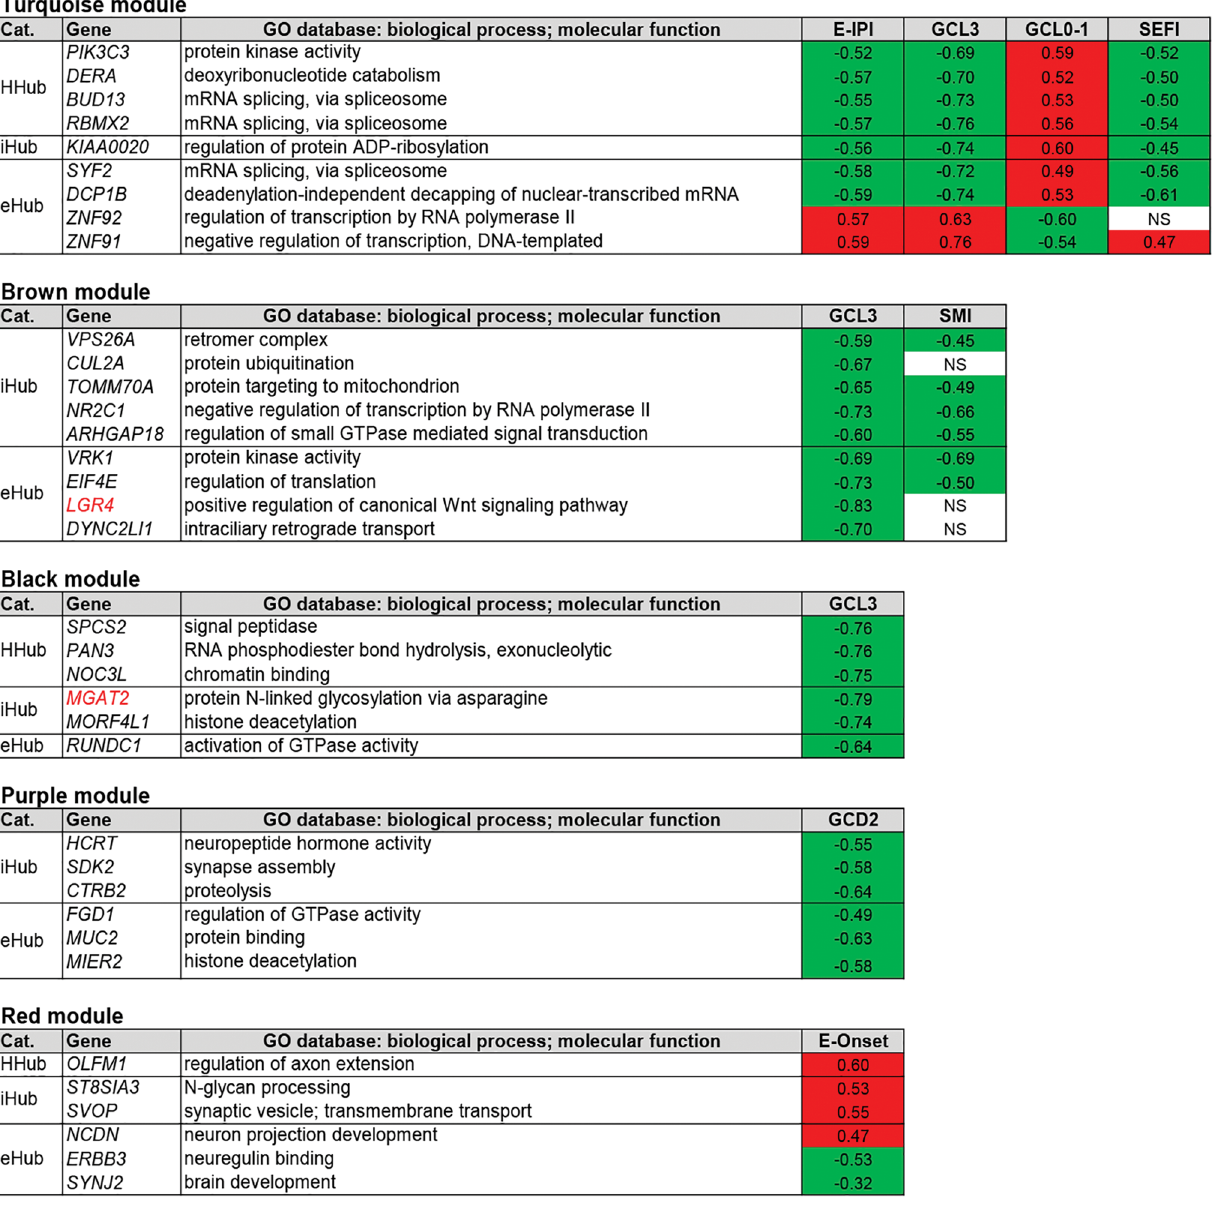
Figure 5. High hierarchy genes (Hhubs, iHubs, and eHubs) of the meta-module II present in modules highly associated with at least one trait. Each HH gene is identified by its hierarchical categorization and GO biological process or molecular function. Genes that are HH and HGS (see Table 2) appear in red lettering. Columns in red or in green indicate genes with positive (i.e. hyper-expressed) or negative (i.e. hypo-expressed) GS values for a specific trait, respectively. NS indicates gene with non-significant ( P ≥ 0.05) GS value for the specific trait. E-IPI stands for early IPI; E-Onset stands for early onset; SEFI stands for severe executive function impairment; SMI stands for severe memory impairment. The abbreviations-GCD2, GCL0-1, GCL3-refer to histopathological alterations, as described in the Results and Material and Methods In the yellow module nine out of the eleven HH genes are positively correlated with GCD2 (Fig. 4). The HHub TANC2 and the eHub SLC25A18 , both hyper-expressed, belong to the glutamatergic excitatory system 36,37 , whose dysfunction leads to hyperexcitatory neural networks and neurotoxicity 38 . The iHub SPOCK1 , also hyper- expressed, encodes the proteoglycan testican, which is expressed in hippocampal pyramidal neurons and has a functional role in reactive gliosis 39 . Reactive gliosis is a quite common finding in drug resistant TLE 27 . Notewor- thy, the Hhub CYB5D2 , that codes for neuferricin and is involved in hippocampal neurogenesis 40 , is negatively correlated with GCD2. In the green yellow module the only gene positively correlated with GCD1 is the eHub FBXW7 , which exerts a protective role against glutamate receptor-mediated excitotoxicity 41 . Finally, in the magenta module, all but